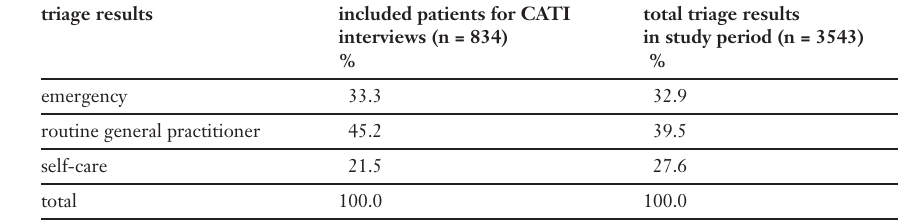
Patient intention, triage advice and patients’ behaviour in five triage cate-